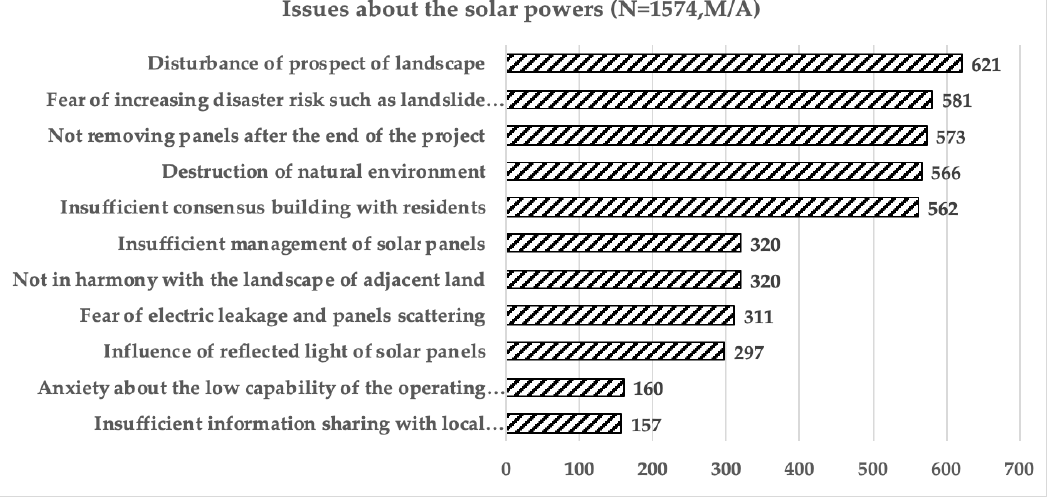
Figure 3. Survey results on the issues recognized by local governments (M/A). Source: Own survey data.